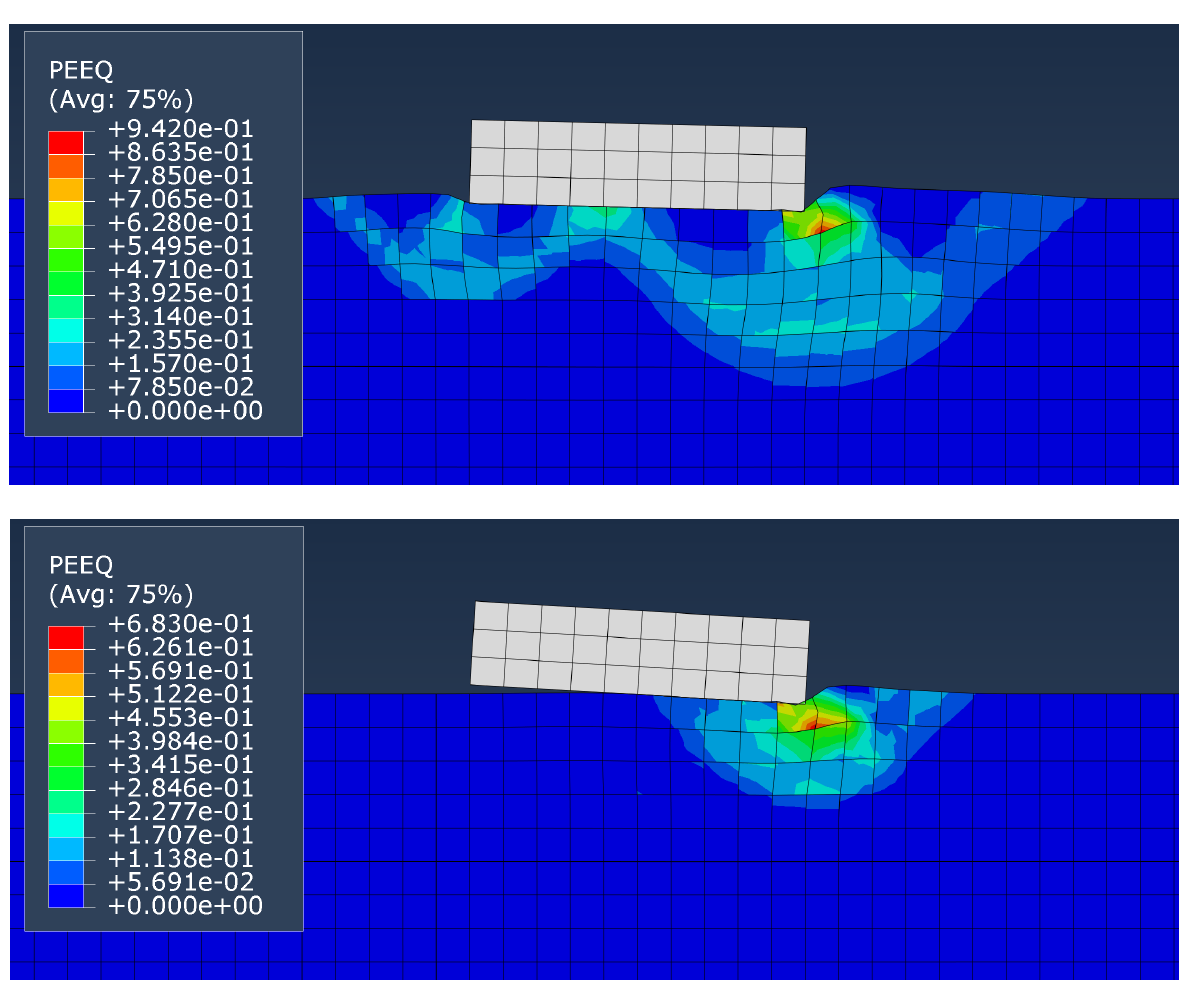
= 1 m and θ = 10 m v h